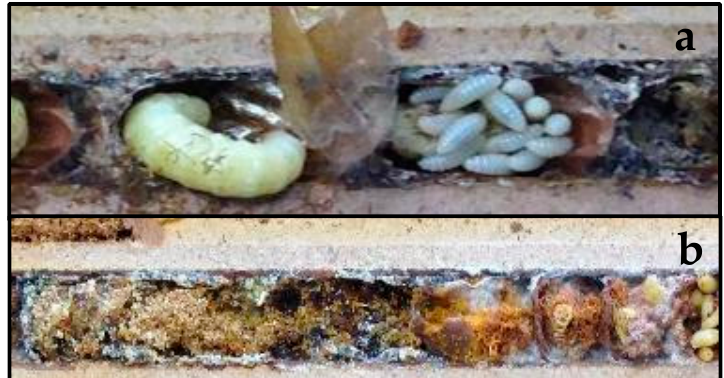
Figure 4. Natural enemies found in M. sculpturalis brood cells. ( a ) Prepupae of Monodontomerus obscurus ( right ) next to intact M. sculpturalis prepupa ( left ). ( b ) Larvae of Cacoxenus indagator (right).